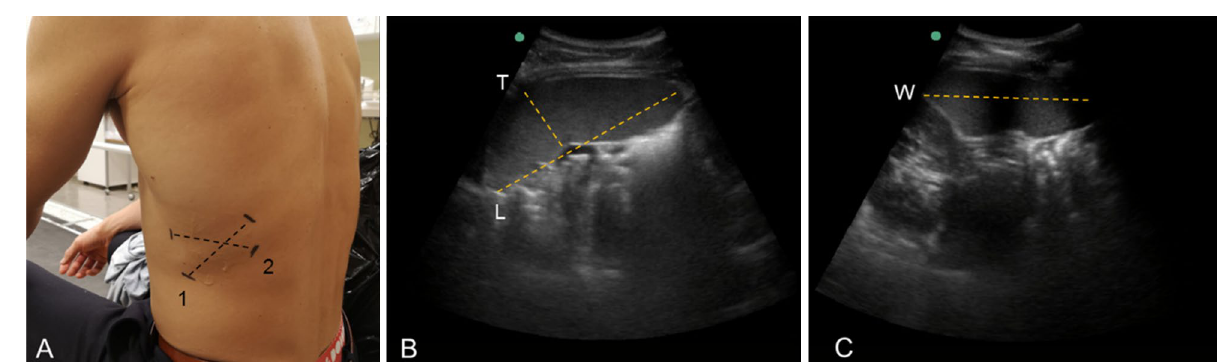
Figure 1. Experimental protocol for test 1 and test 2. Both tests were identical and started with 10 min of lying (supine) rest, after which participants were moved to a sitting 5-min rest, at which splenic measurements were collected each minute for baseline (resting) splenic volume assessment. Thereafter, the maximal voluntary apnea was performed and immediately on termination, a 5-min resting recovery period followed, wherein splenic measurements were collected for apnea-induced volume assessments. Test 1 and test 2 were separated by 15 min, during which the participants were cleared of all testing equipment and asked to leave the laboratory, to return when test 2 should start.